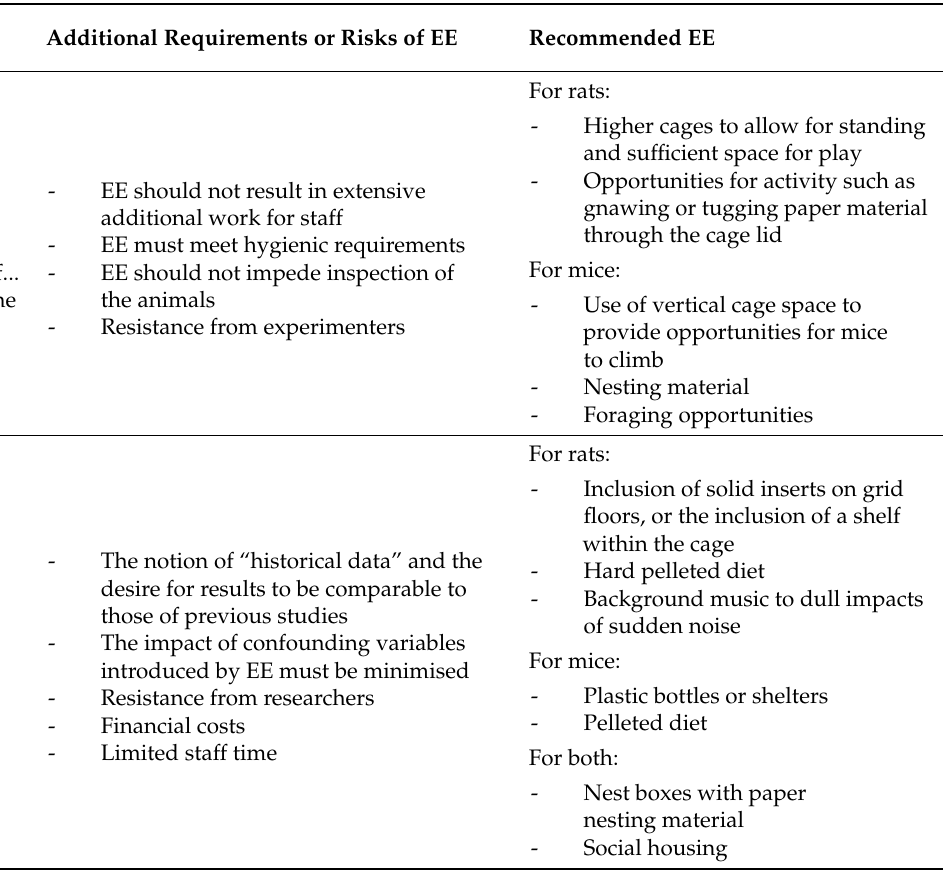
Table 1. Summary of definitions, goals, requirements or risks of environmental enrichment (EE), and recommended forms of EE, as described in review articles on the topic. “Additional requirements or risks of EE” consisted of any aspect that was indicated by authors, using words like “must” or “should”, as a